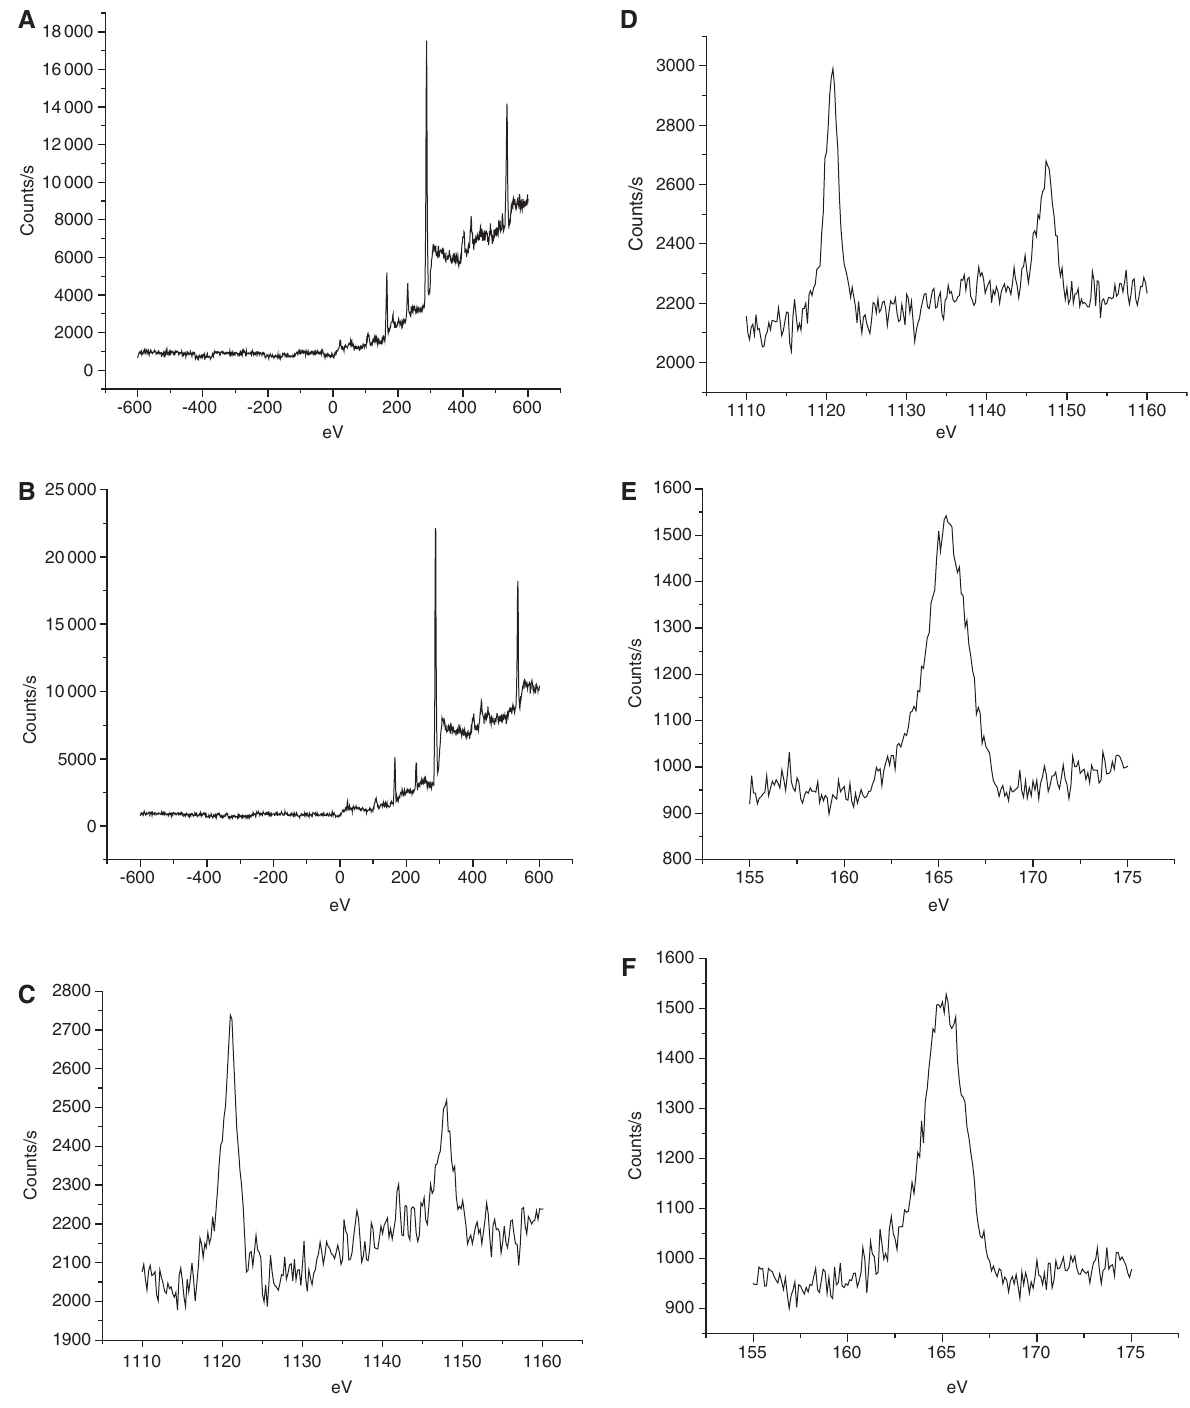
] and [Ga(chedtc) 3